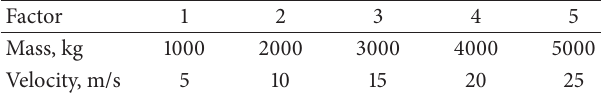
Table 2: Factors and levels of